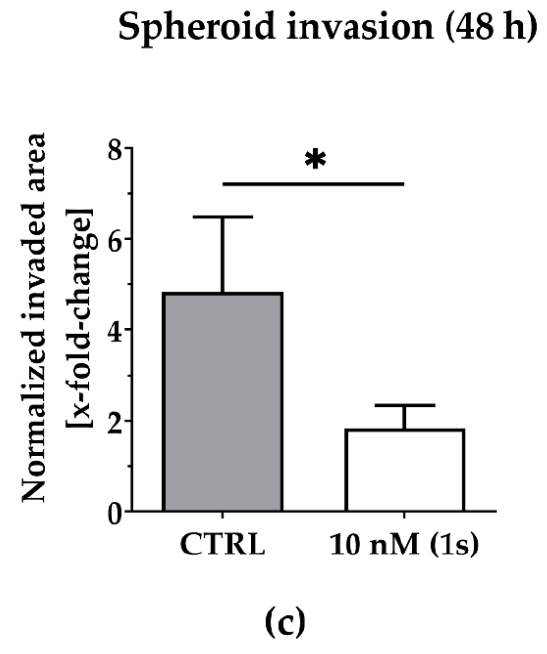
Figure 6. Compound ( 1s ) blocks TNBC monoculture spheroid invasion in a matrigel ® -based extracellular matrix (ECM). Monoculture spheroids were generated for 72 h before matrigel ® was applied for ECM formation. Spheroids were grown for another 48 h without (CTRL) or with 10 nM ( 1s ). ( a ) Invaded area was measured using Fiji (open-source software [70]; version 1.52i) with manually picked positions (white squares) to determine the outline (yellow line) of the spheroid area within 0 h and after 48-h treatment. ( b ) Representative brightfield images of the monoculture spheroids. Scale bar: 500 µ m. ( c ) Invaded area is calculated by normalizing the spheroid area after 48 h treatment to the spheroid size at 0 h. Statistical difference was calculated with an unpaired t -test (* p < 0.05). Columns represent the mean ± SD ( n = 3).